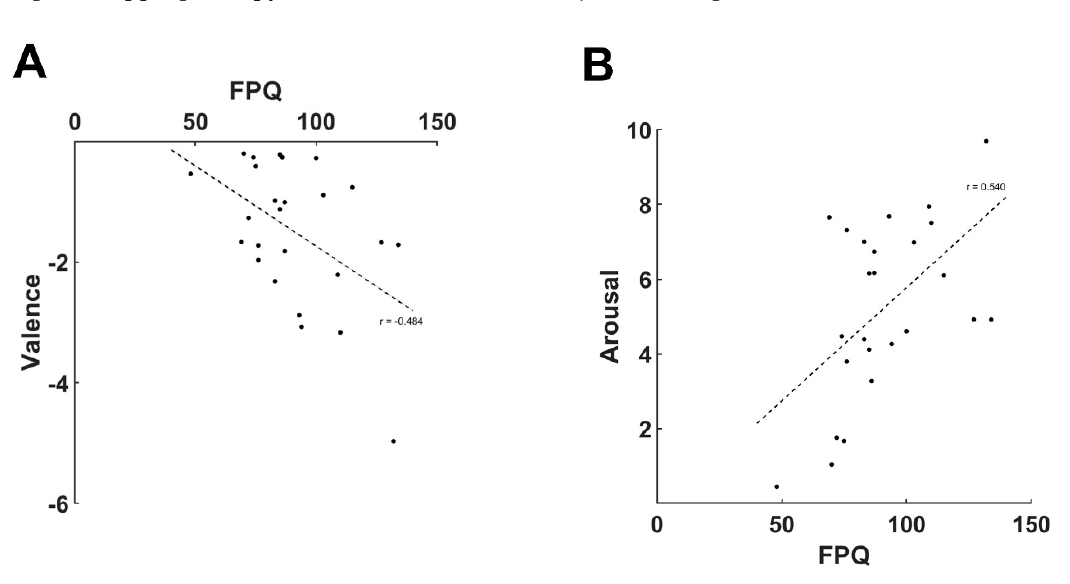
Figure 4. Correlation analysis between the emotional components of cupping therapy and scores on the Fear of Pain Questionnaire. Greater fear of pain was associated with increased feelings of unpleasantness and arousal in response to cupping therapy images, A : Correlation analysis between the valence ratings for cupping therapy and FPQ scores. B : Correlation analysis between the arousal ratings for cupping therapy and FPQ scores.